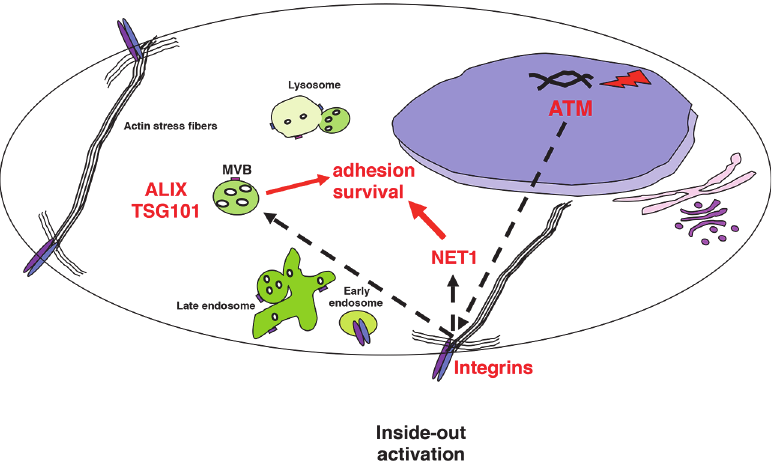
Fig 9. Summary of the study and significance. Genotoxin-induced DNA strand breaks activate the DNA damage response coordinated by the ATM kinase, which promotes the inside-out integrin β 1 activation, leading to enhanced cell adhesion/spread, which is also dependent on the NET1-RhoA axis. The integrin response further relies on the ALIX and TSG101-dependent intracellular trafficking. The ESCRT-mediated integrin signaling is required to promote anchorage independent